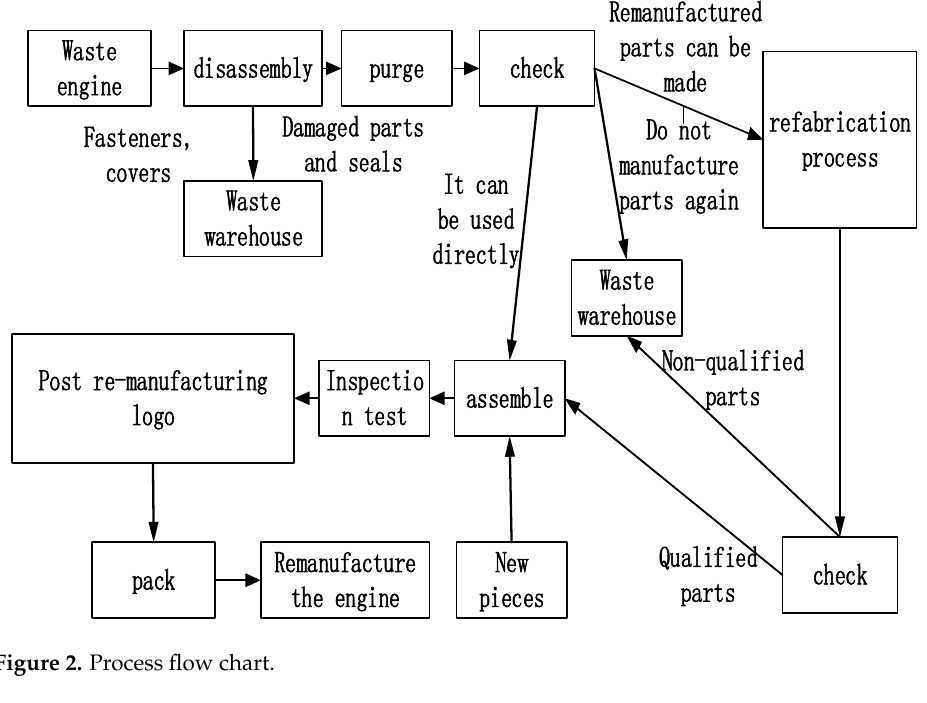
Figure 2. Process flow chart.